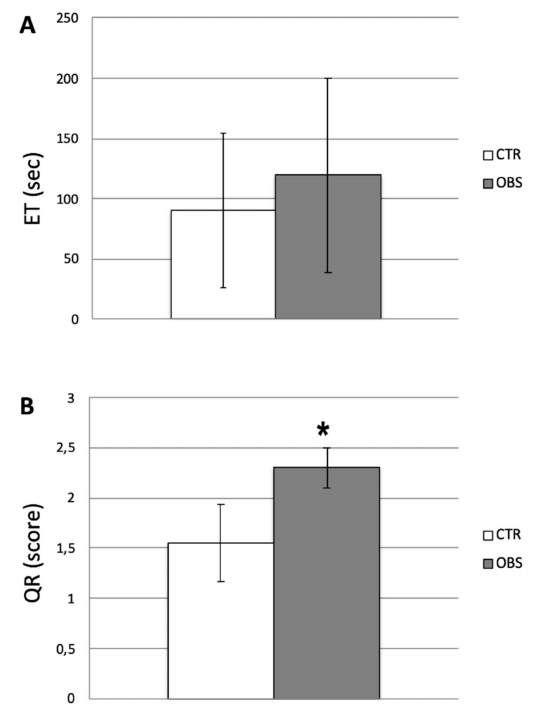
Figure 3. Behavioral evaluations of haptic performances in obese (OBS) vs. control (CTR) groups. ( A ) Mean exploration time (ET) expressed in seconds. ( B ) Mean quality of reproduction (QR) considering the score obtained. Unpaired t-test showed statistical significance for P < 0.0001 (*).